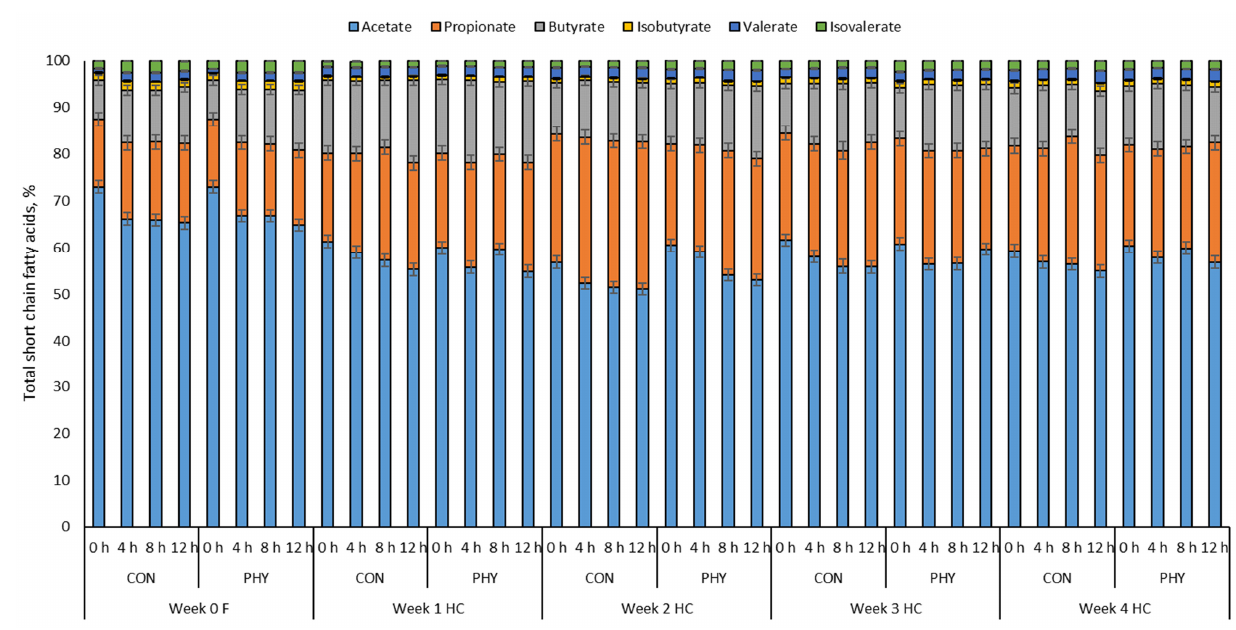
Figure 2. Variation of ruminal short chain fatty acid fermentation from 0 to 12 h post-feeding in cows fed either forage-only (F) or a high concentrate (HC), without supplementation (CON) or supplemented (PHY) with a phytogenic feed additive based on L-menthol, thymol, eugenol, mint oil ( Mentha arvensis ) and cloves powder ( Syzygium aromaticum ). p -Values: Acetate, Time < 0.01, Trt = 0.26, Diet < 0.01, Time × Trt × Diet × Week < 0.01; Propionate, Time < 0.01, Trt < 0.05, Diet < 0.01, Time × Trt × Diet × Week < 0.01; Butyrate, Time < 0.01, Trt = 0.23, Diet < 0.01, Time × Trt × Diet × Week < 0.01; Isobutyrate, Time = 0.36, Trt = 0.28, Diet < 0.01, Time × Trt × Diet × Week < 0.01; Valerate, Time < 0.01, Trt = 0.30, Diet < 0.01, Time × Trt × Diet × Week < 0.01; Isovalerate, Time = 0.45, Trt < 0.05, Diet < 0.01, Time × Trt × Diet × Week < 0.01.